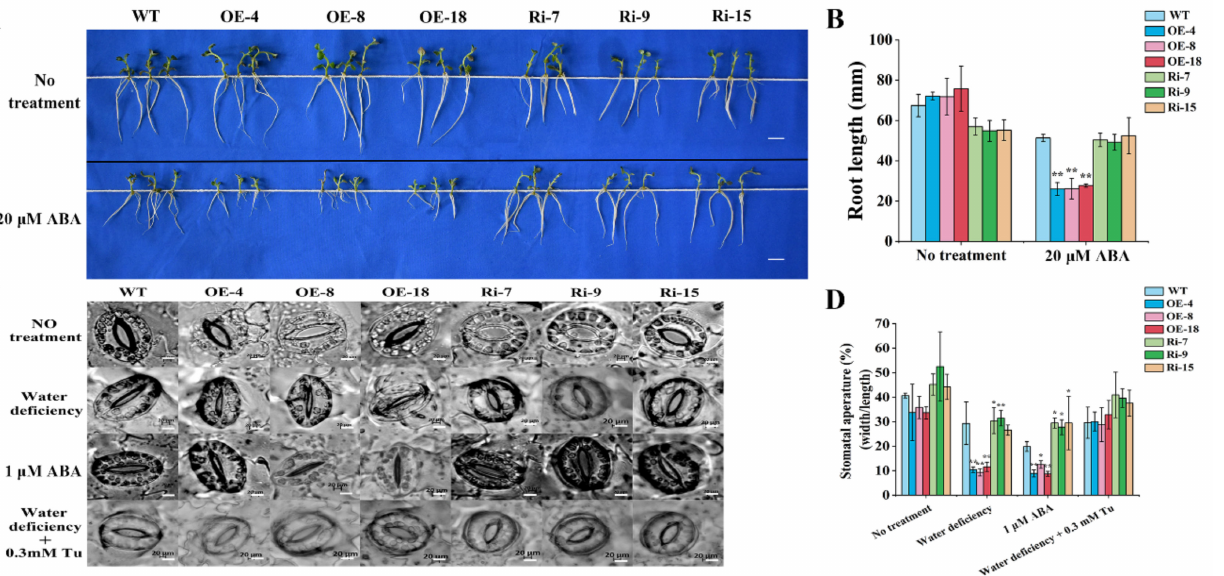
Figure 6. Root lengths and stomatal movements of StCIPK10 transgenic and WT lines. ( A ) Seedlings grown on 1/2 MS medium and 1/2 MS medium with 20 µ M ABA for 14 days. Bars = 1 cm. ( B ) Root length of StCIPK10 transgenic and WT seedlings. ( C ) Stomatal closure under water deficiency, ABA and TU treatments. Bars = 20 µ m. ( D ) Statistical analysis of stomatal width/length ratio. Experiments were repeated three times independently. Data are mean ± SD ( n = 3 ). Significance compared with no treatment was determined using the ANOVA Duncan’s test; p < 0.05, significant (*); p < 0.01, highly significant